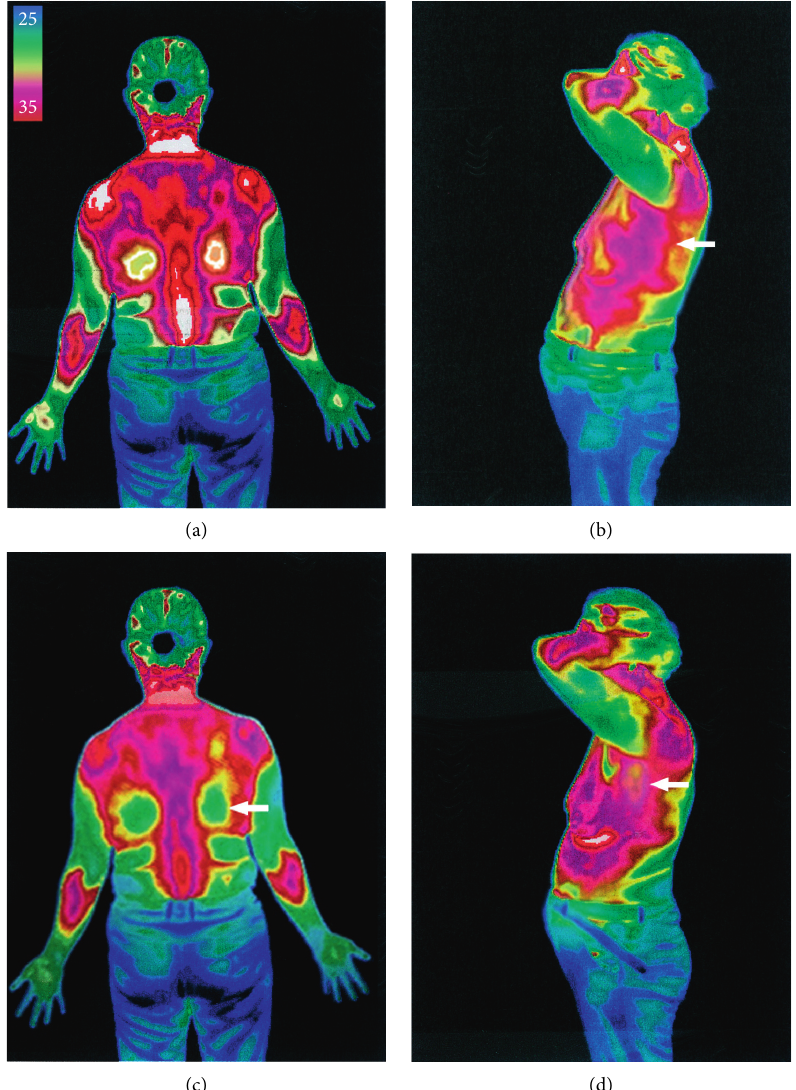
Figure 3: Comparison of infrared thermograms at T 2 and T 0 for typical cases in the group treated. (a) Body surface skin temperature on the back of the chest at T 0 , 35.5. (b) Body surface skin temperature in the right axilla at T 0 ; the arrow indicates the pretreatment infrared thermogram of the painful area, showing a high body surface temperature signal at 35.6 ° C. (c) Body surface skin temperature on the back of the chest at T2, 34.5. (d) Body surface skin temperature in the right axilla at T 2 . The arrowed area shows a relatively low-temperature signal of 34.3 ° C on infrared